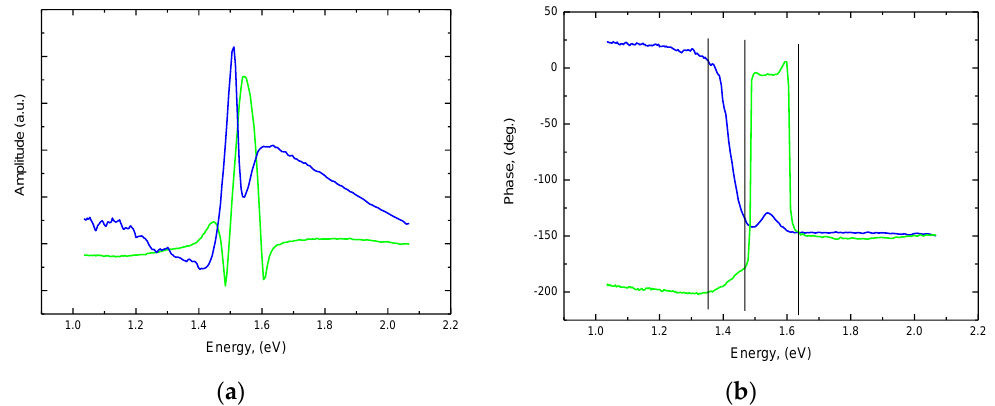
Figure 6. Amplitude ( a ) and phase ( b ) spectra for the ground (green lines) and etched (blue lines) Cd 0.95 Be 0.05 Te sample at 126 Hz of modulation frequency.